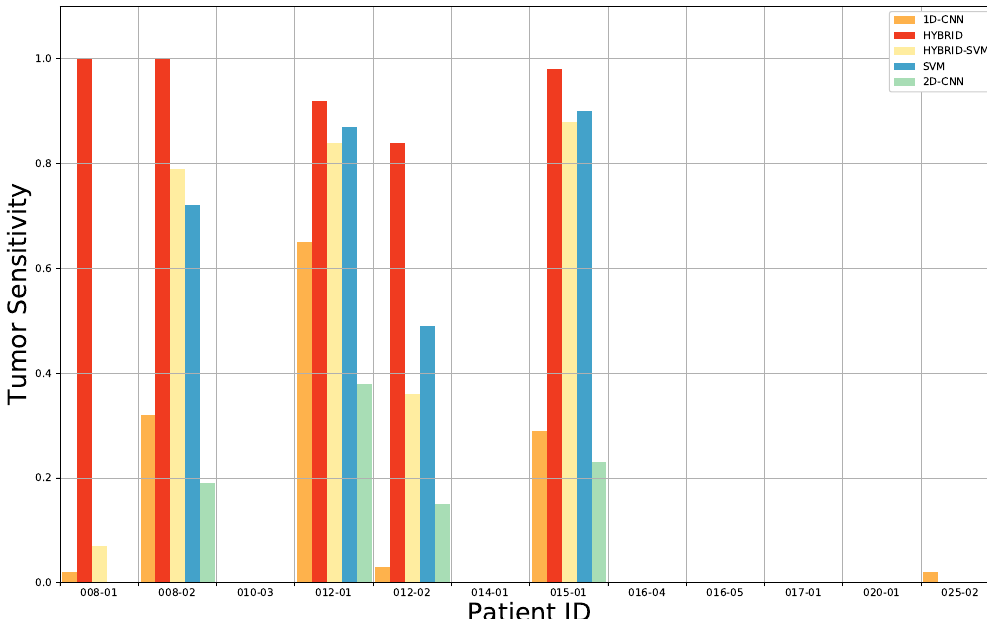
Figure 6. Average sensitivity results for the tumor tissue classification of the leave-one-patient-out cross-validation of the four-class classification for each method: 1D CNN, 3D–2D hybrid CNN, 3D–2D hybrid CNN + SVM, only SVM and the 2D CNN.